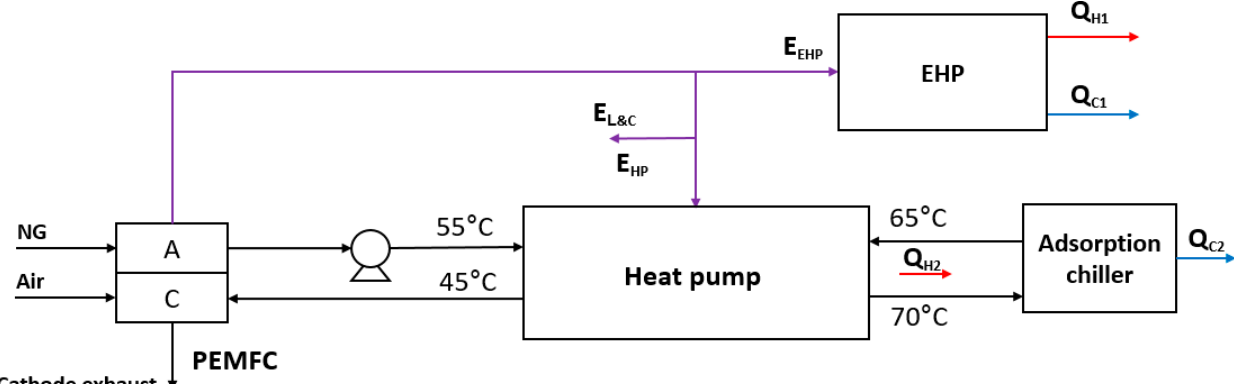
Figure 1. The layout of the proposed tri-generation system.